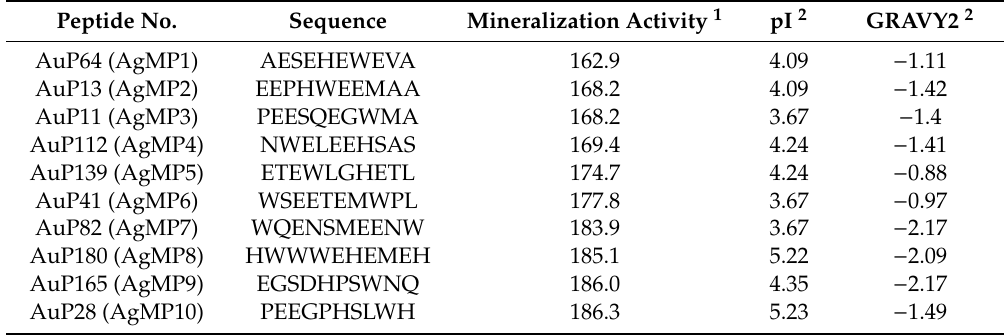
Table 1. List of Ag mineralization peptides (TOP10) screened, and their physical properties.